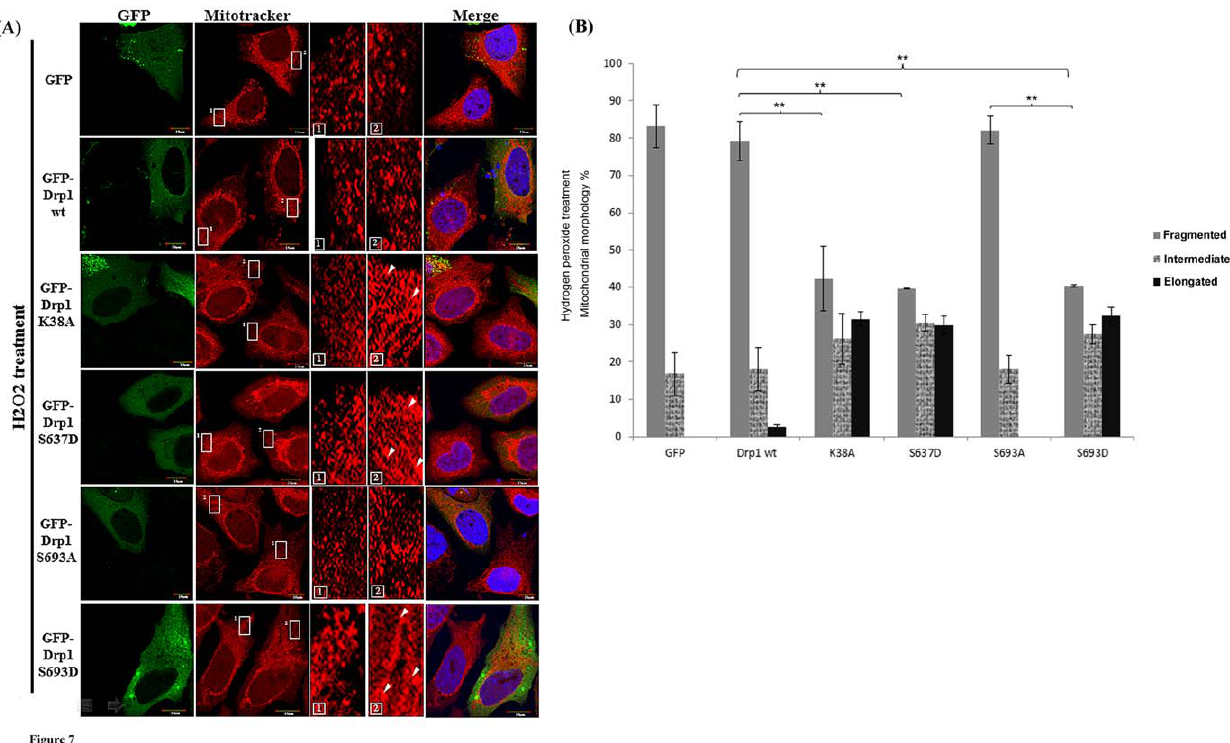
Figure 7. Mitochondrial dynamics of HeLa cells with Drp1 wt and mutants treated with H 2 O 2 . (A) HeLa cells were transfected with GFP- tagged Drp1wt or other mutants for 24 hours. Then cells were treated with 500 m M H 2 O 2 for another 24 hours. Mitochondrial morphology of HeLa cells was observed by staining with Mitotracker under confocal microscopy. Cell nuclei were counter-stained by using DAPI. Insets are magnifications of the Mitotracker signal at the indicated areas. Inset 1 represents the non-transfected cells, and inset 2 indicates the transfected cells. Indications (white arrows) represent typical elongated mitochondria morphology. (B) Statistical results demonstrated mitochondrial morphology of HeLa cells with or without Drp1 expression under H 2 O 2 treatment for 24 hours; over 100 transfected cells were categorized into 3 groups depending on mitochondrial morphology. **p , 0.001.